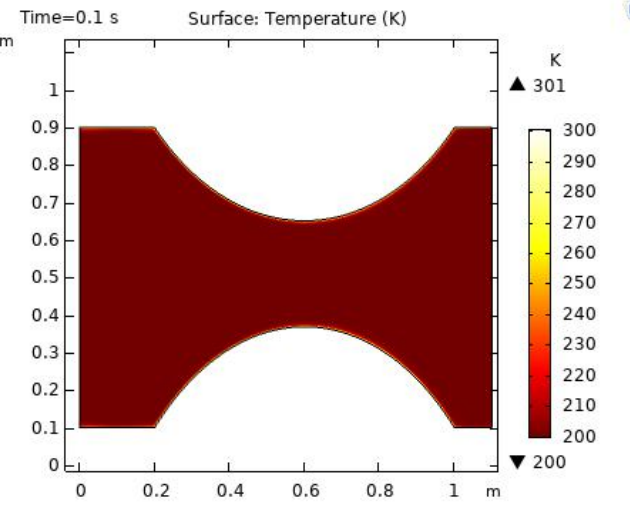
Figure 11. The temperature profile at t = 0.1 s.